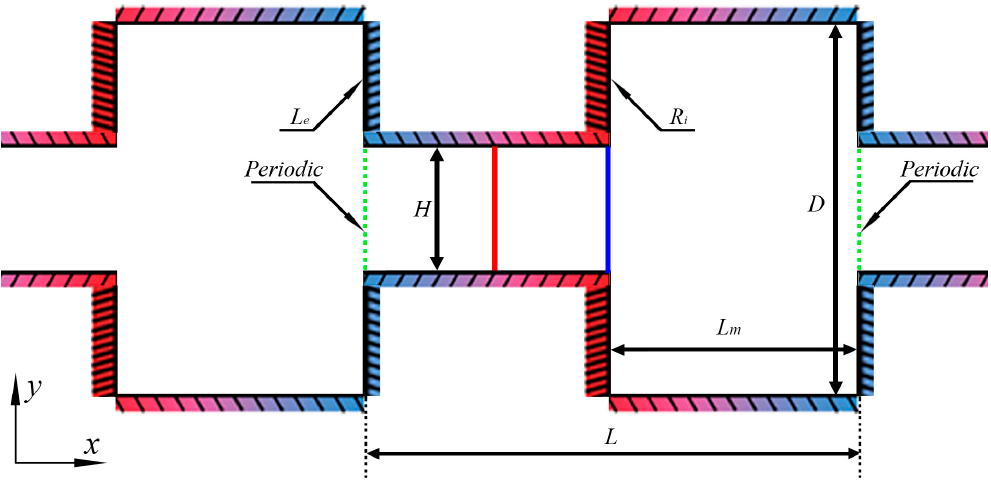
Figure 2. Configuration and geometric parameters.